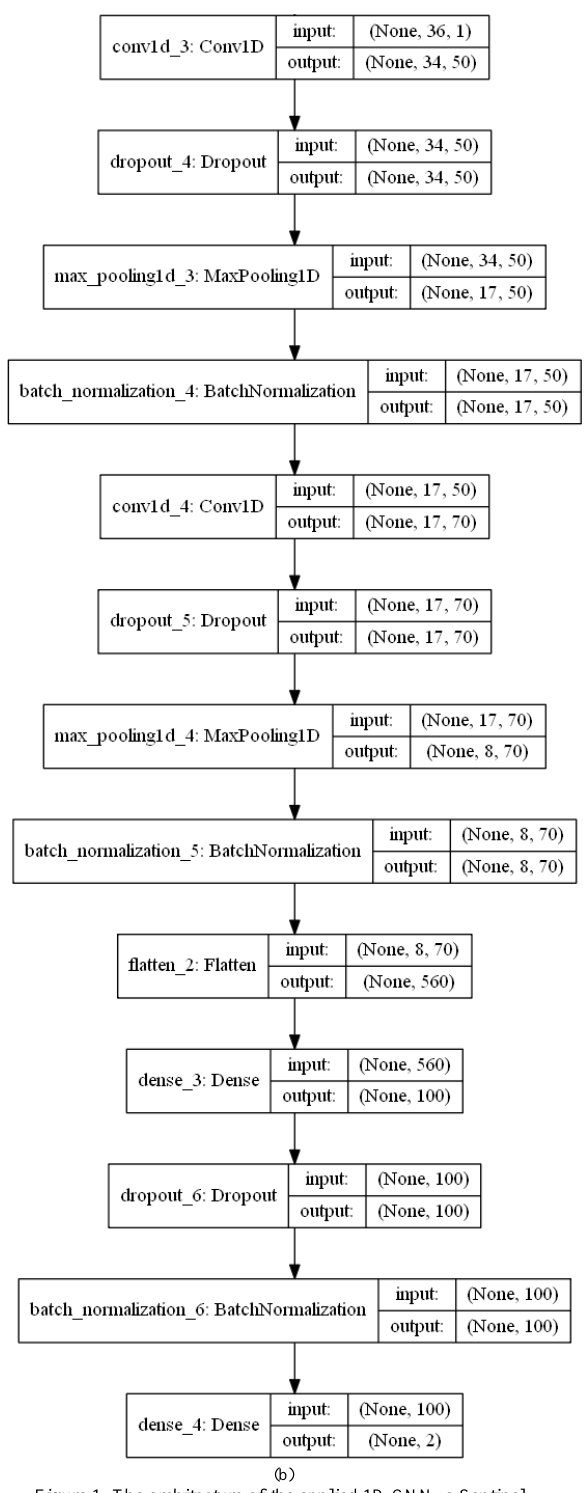
(b) Figure 1: The architecture of the applied 1D CNN; a:Sentinel- 1;b:Sentinel-2